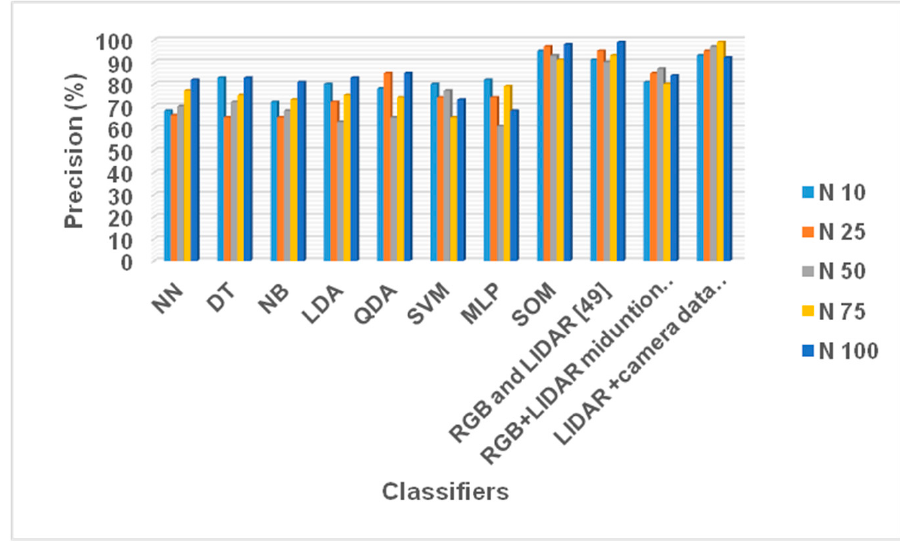
Figure 14. Comparison of Precision.